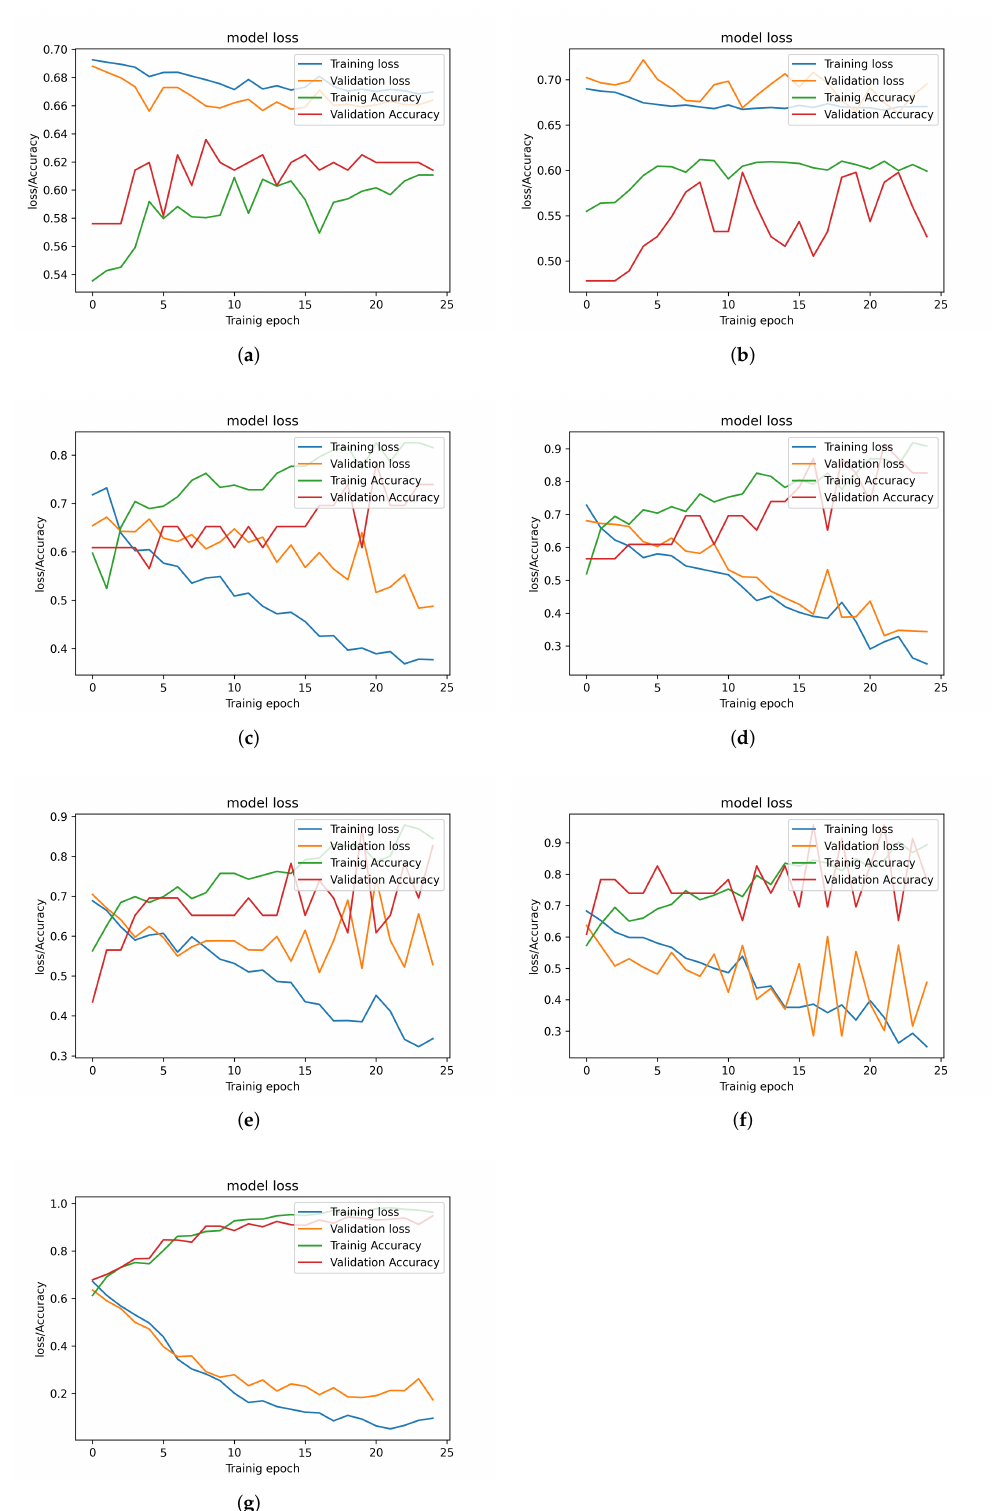
Figure 11. Training and validation loss and accuracy for different trained models (using 1 Sensor reading. ( a ) LSTM model. ( b ) 2 Stacked-LSTM model. ( c ) CNN model. ( d ) 2 Stacked-CNN model. ( e ) CNN-LSTM model. ( f ) CNN-(2LSTM) model. ( g ) (2CNN)-LSTM